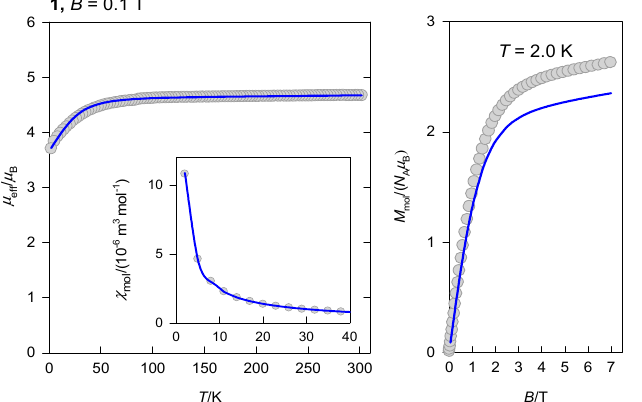
Figure 3. Left: temperature dependence of the effective magnetic moment; inset-molar magnetic susceptibility; right-field dependence of the magnetization. Lines–fitted with D / hc = 29.6 cm − 1 , g x = 2.49, g z = 2.12, χ TIM = 2.7 × 10 − 9 m 3 mol − 1 [SI].